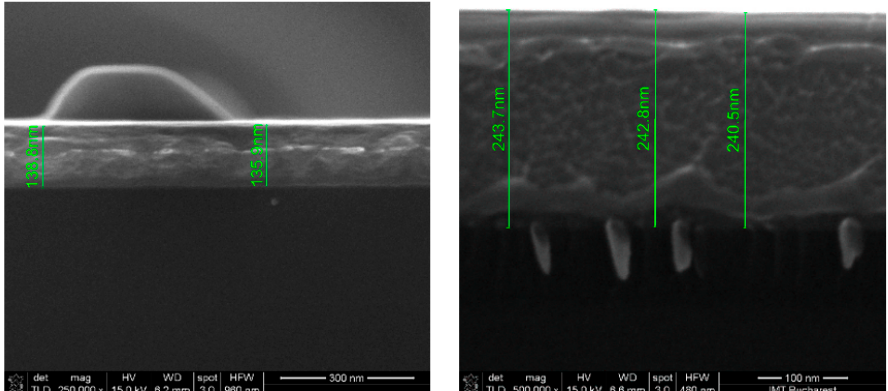
Figure 5. Cross-section obtained images of thin films and of their thicknesses which can be readable on marked bars of the HEA6 thickness ~1.37 × 10 − 7 m on the left side, and of the HEA2 thickness ~2.32 × 10 − 7 m on the right side.